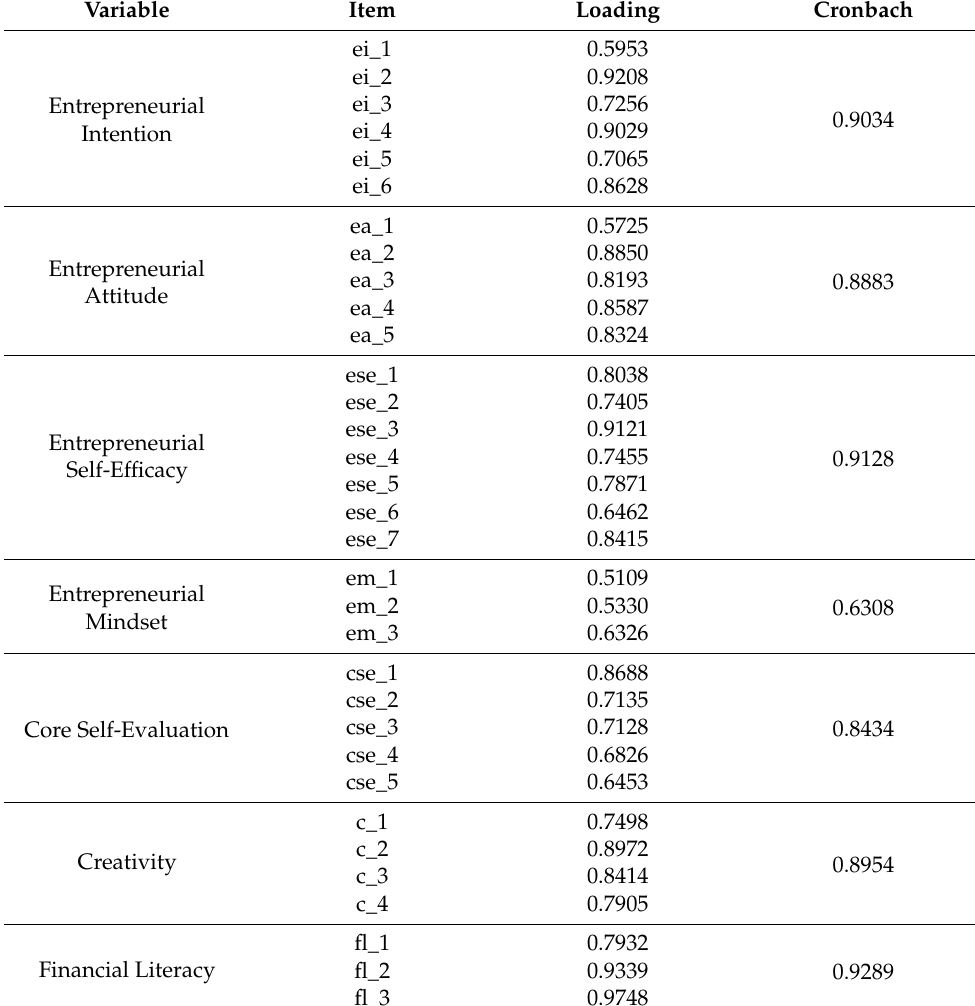
Table 3. The factor loadings and Cronbach’s alpha values obtained from the factor analysis conducted on the pre-program data. Variable Item Loading